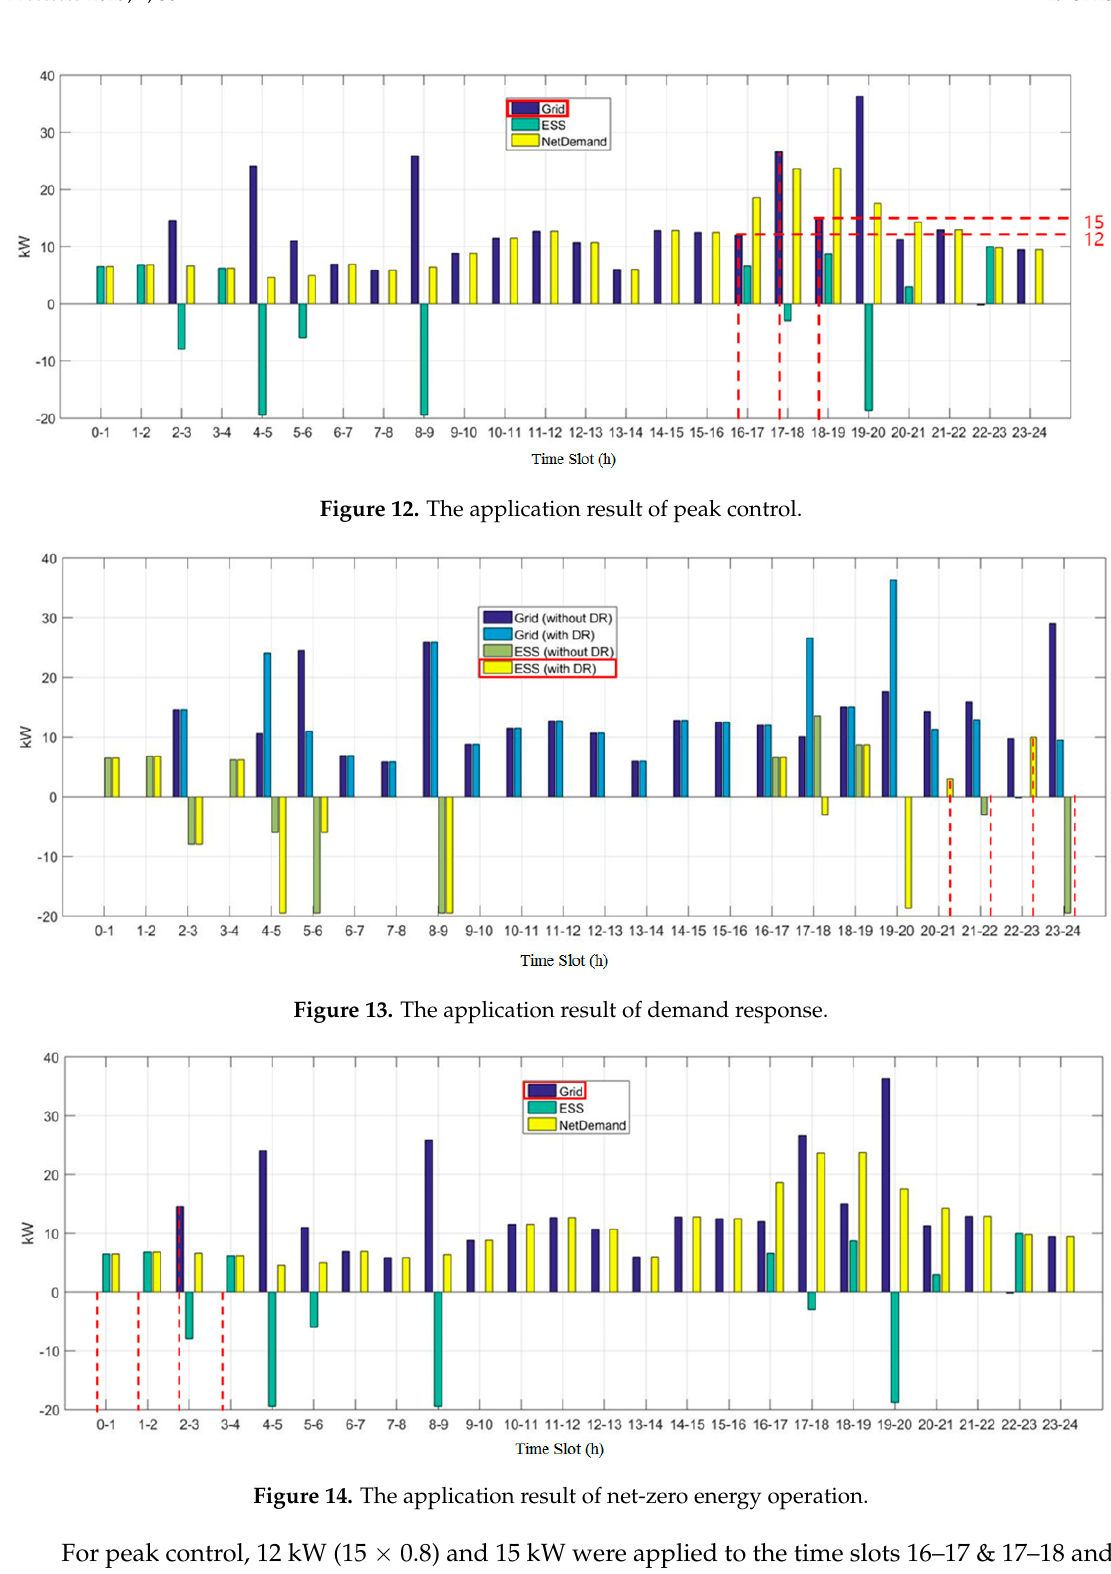
Figure 14. The application result of net-zero energy operation.